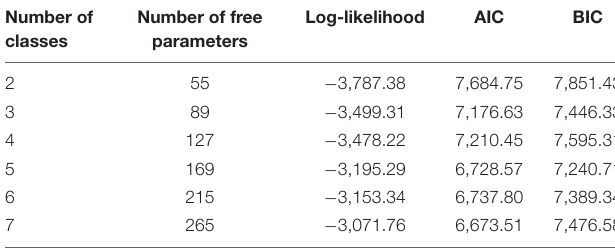
TABLE 2 | Pearson’s correlations for condition, gender, age, pretest and posttest balance beam scores, and the difference between pretest and posttest.